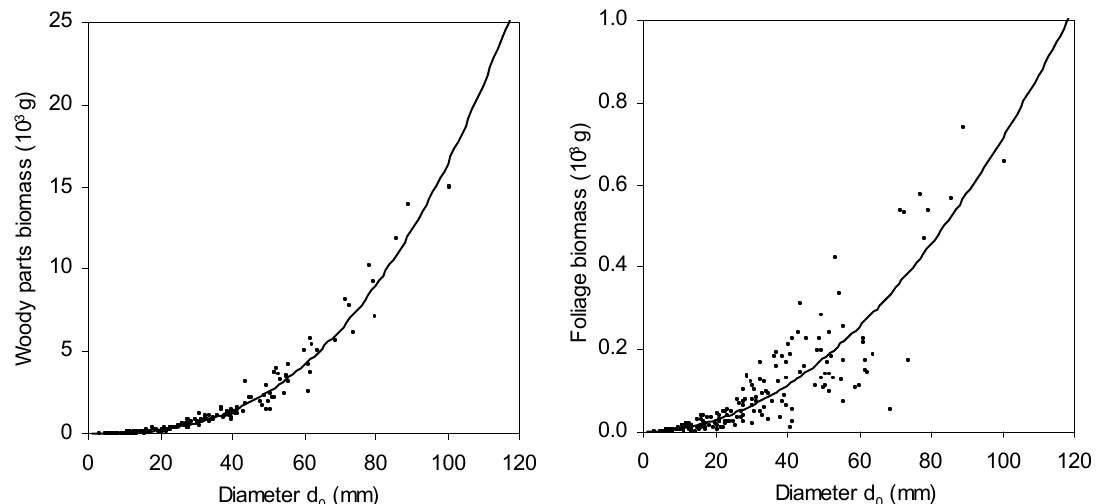
Figure 4. Biomass of woody parts (left plate) and foliage (right plate) in the sampled common aspen trees plotted against the d 0 stem base diameter (see also Table 6).